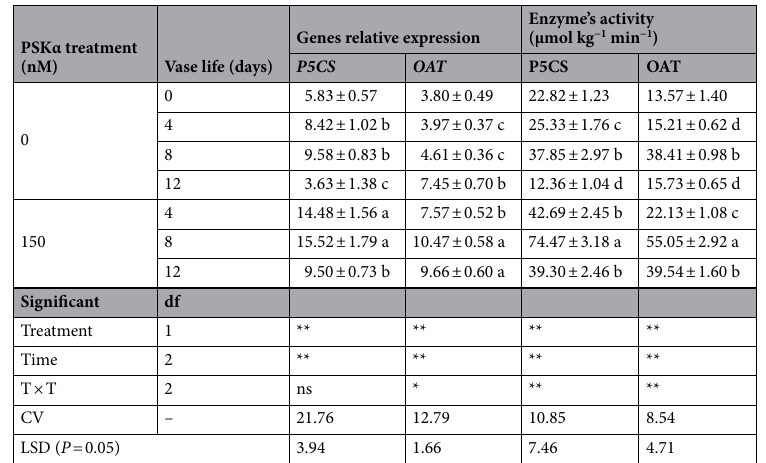
Table 6. P5CS and OAT genes expression and enzymes activity in petals of rose flowers treated with PSKα at 0 and 150 nM during vase life at 20 °C for 12 days. Data shown are mean values of n = 3, and the error bars represent standard errors of the means. Mean values followed by different letters indicate they are different by LSD test at P < 0.05.